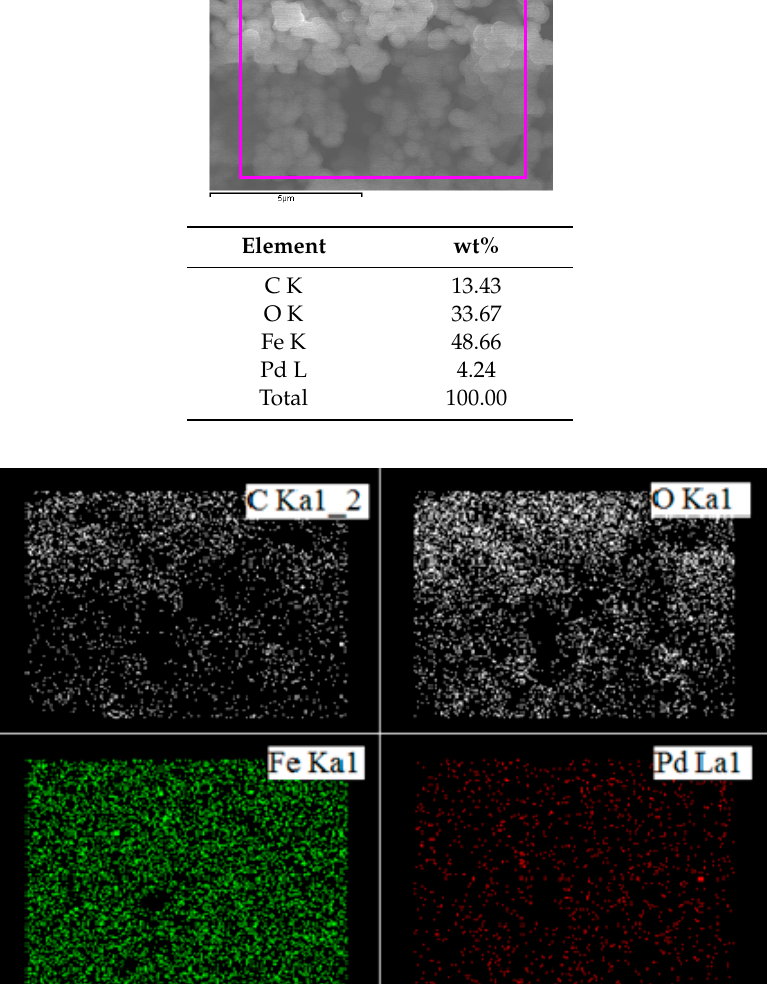
Figure 2. Energy-dispersive x-ray spectroscopy (EDS) mapping of Fe 3 O 4 @PDA@Pd.